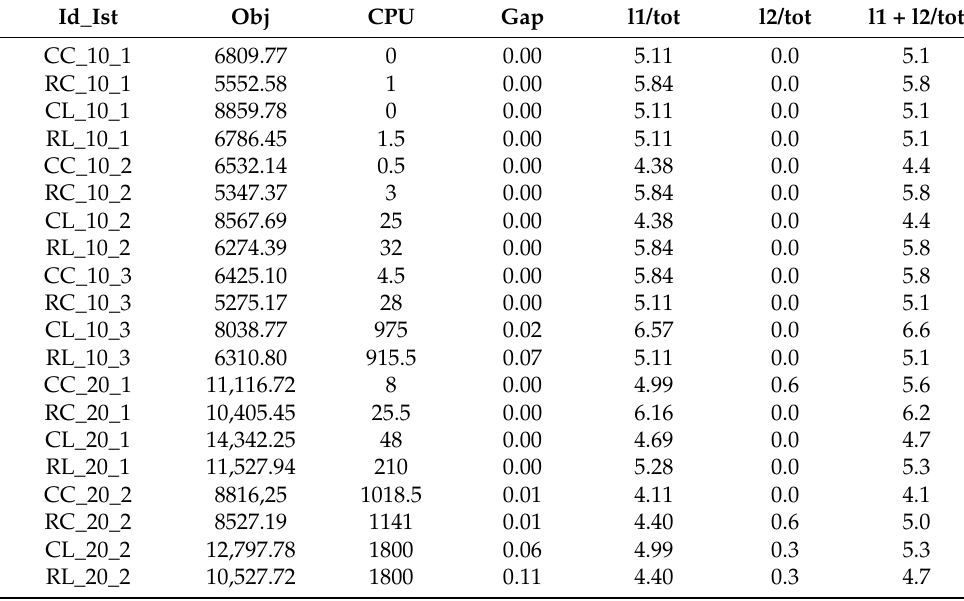
Table 1. Results obtained by using mode